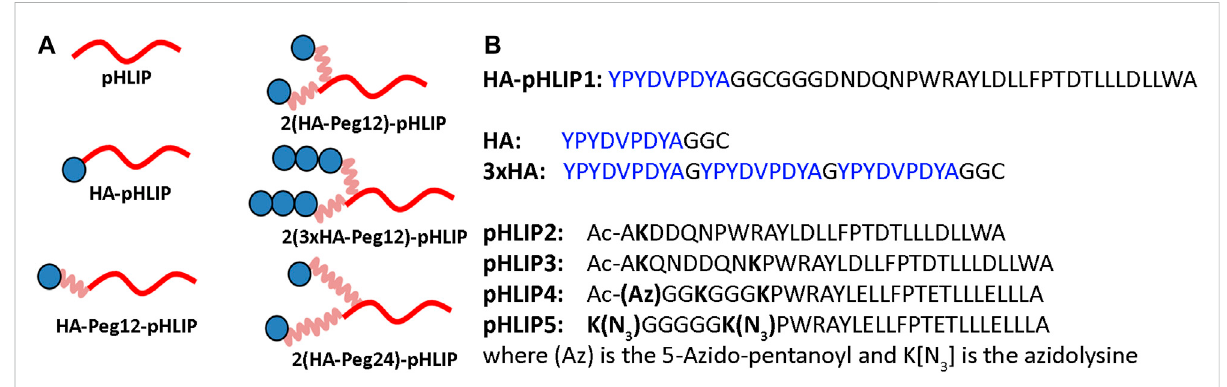
FIGURE 3 HA-pHLIPconstructs (A) :SchematicrepresentationoftheHA-pHLIPagents,whereHAisshownasbluecircle,Peglinkersareshowninpinkand pHLIP is shown in red. (B) : Sequences of HA-pHLIP synthesized as a single peptide, the separately conjugated HA and 3xHA units, and several pHLIP peptides are shown. As indicated, some pHLIP peptides had acetylated N-termini (Ac). Peptides pHLIP4 and pHLIP5 consisted of all D amino acids and the other peptides consisted of all L amino